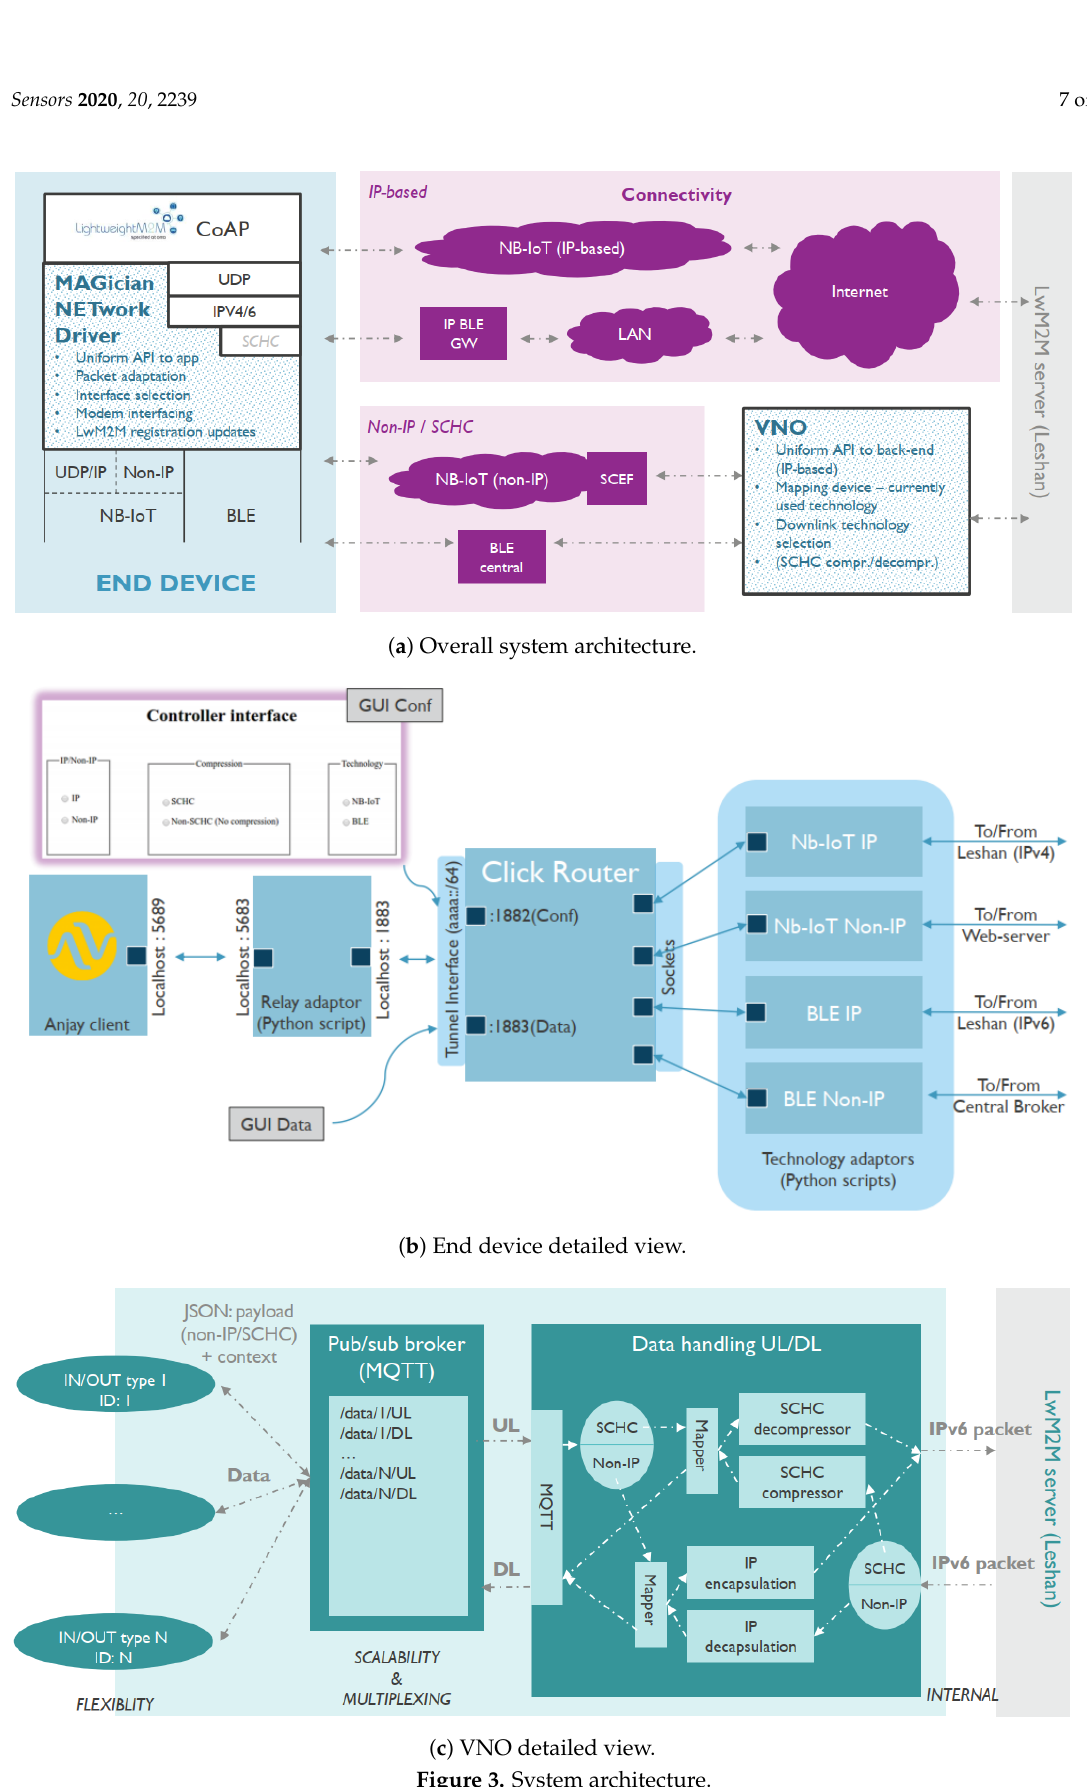
Figure 3. System